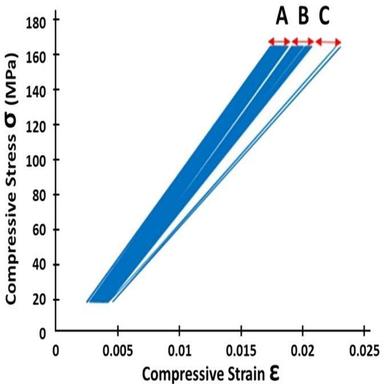
Conventional mechanical testing result for a typical compressive stress vs. strain graph at 70% of σuc. Regions A, B, and C, respectively, displayed the initial, steady state, and failure conditions.